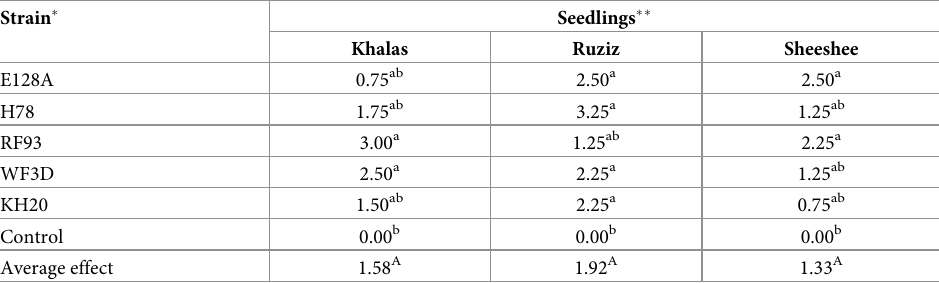
Table 3. Disease severity of five Fusarium strains on date palm seedlings of three local cultivars. Strain �